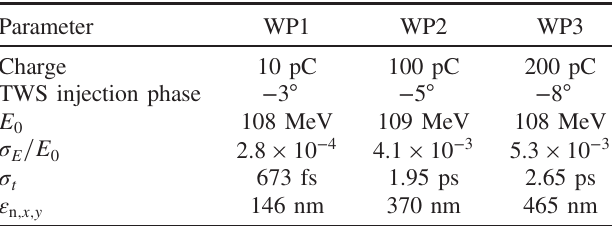
TABLE II. Beam parameters of the three ARES linac working points (WP) at the interaction point ( z ¼ 16 . 8 m), obtained from ASTRA simulations. Initial spatial and temporal profile: Gaus- sian. TWS: traveling wave